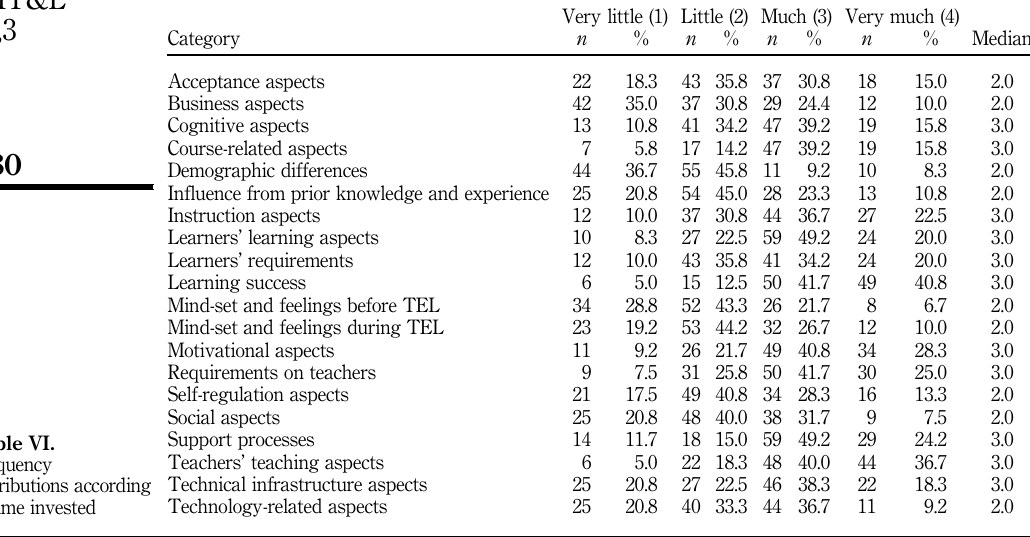
distributions according to time